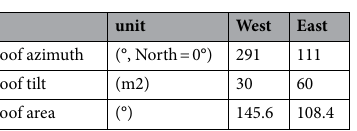
Table 1. Ontowiryo Mosque roof